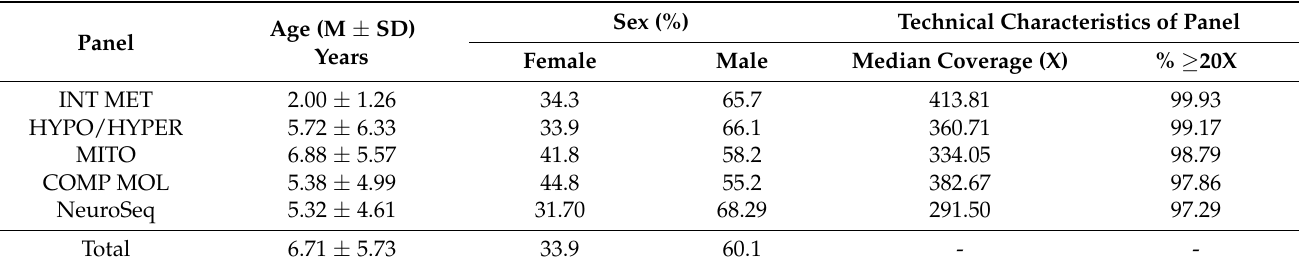
Table 1. Characteristics of the study population (patients’ mean age and sex) and technical characteristics of the panels included in the